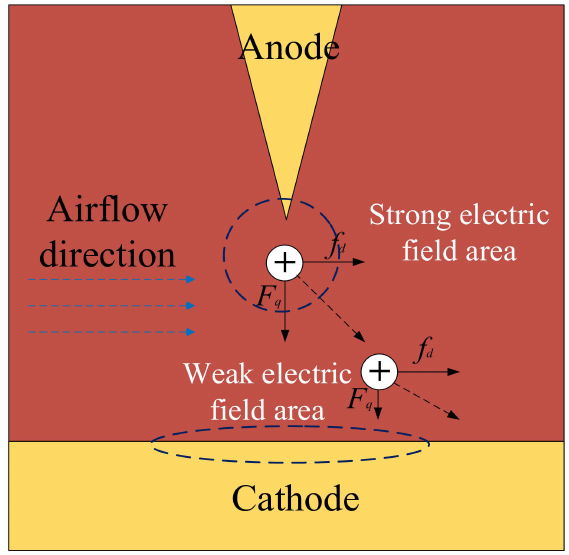
Figure 11. Force analysis diagram of ions in different